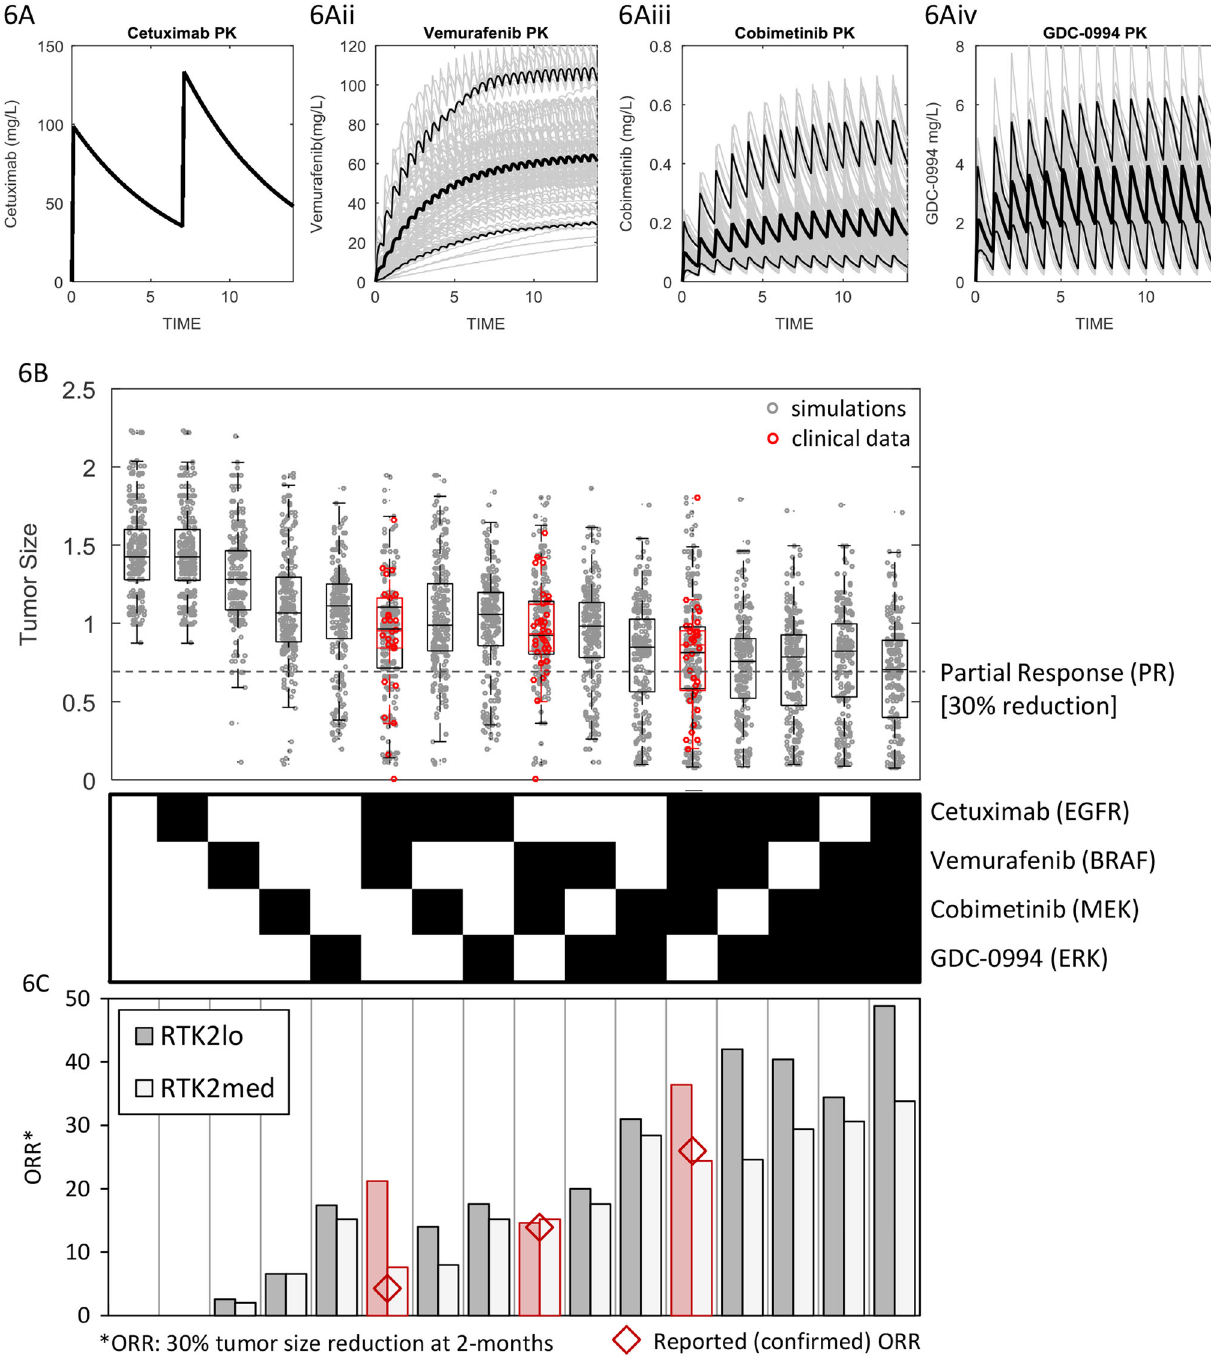
Fig. 6 Simulated pharmacokinetics and tumor responses on 16 drug treatment regimens. a Simulated serum drug concentrations for cetuximab, vemurafenib, cobimetinib, and GDC-0994 dosed at clinical regimens. Median, 5 and 95-percentiles are shown in black lines . b Relative changes in tumor size following two cycles of treatment (8 weeks) on all 16 possible combinations of the four drugs, for prevalence weighted model simulations ( gray ) and clinical data ( red ). c Simulated ORRs for baseline tumors ( RTK2 lo), and those with RTK2 set at 15%